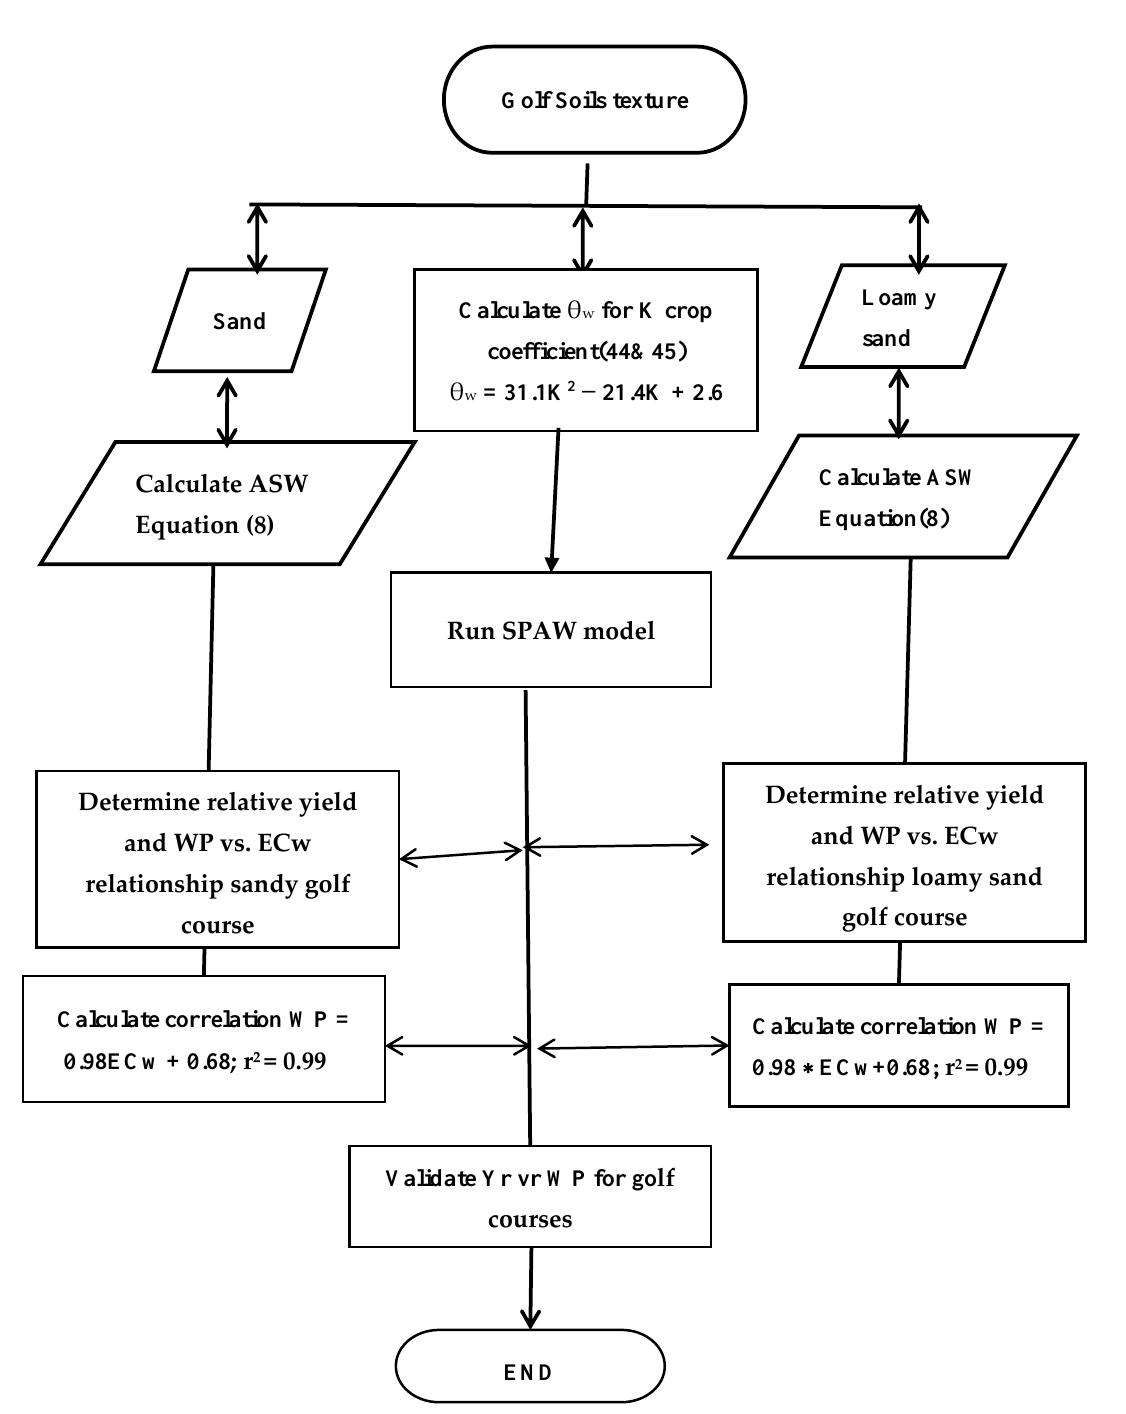
Figure 5. Flowchart describing independent validation of Equations (1) and (2) by processing data collected from experi- ments on golf courses.